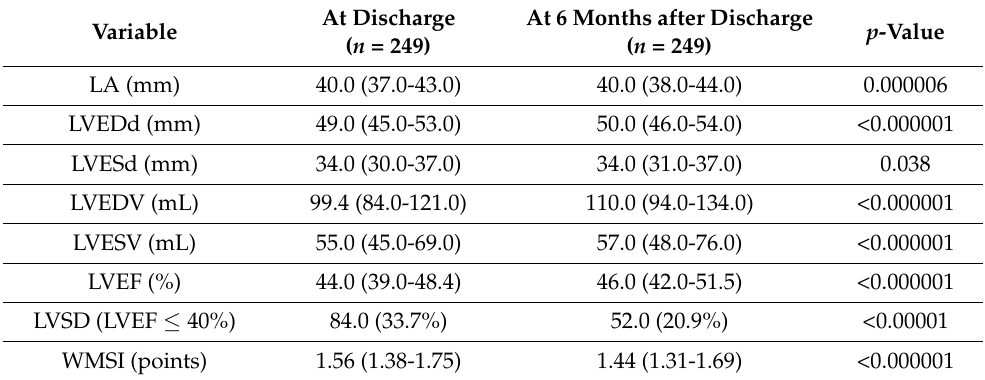
Table 2. Echocardiographic characteristics of the overall study population (median (lower quartile- upper quartile) or number (percent)).